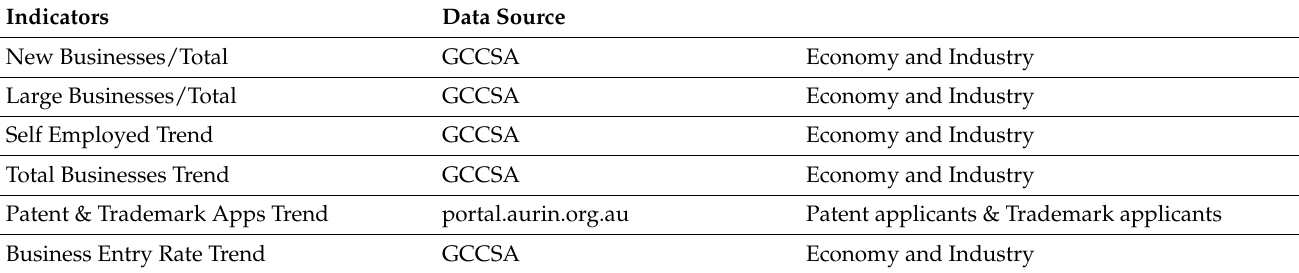
Table A1. Describing the data sources used in the